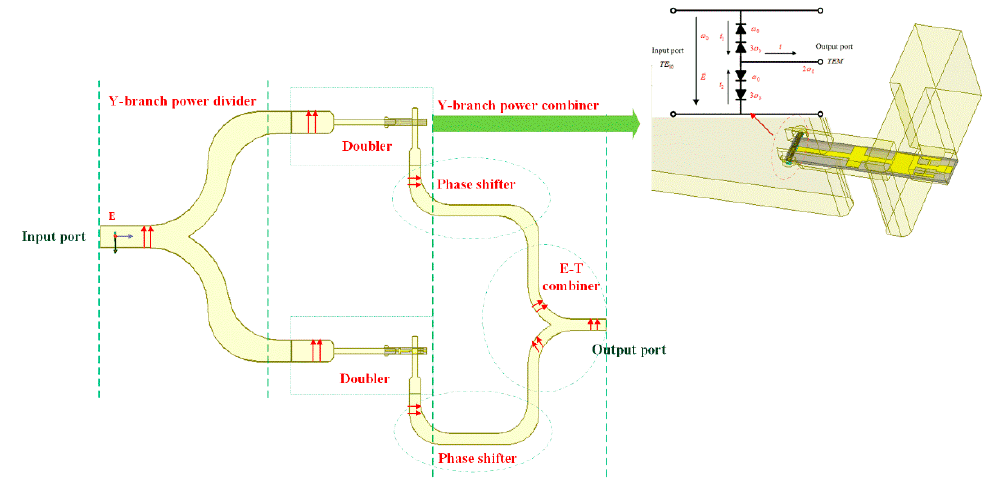
Figure 5. The structure of the 167 GHz doubler based on the two-way power-combined technology.